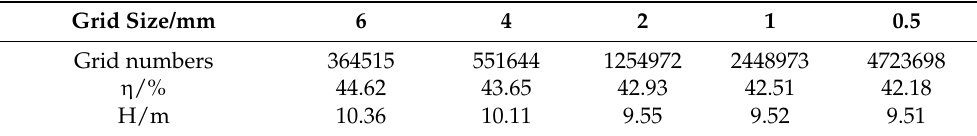
Table 3. The efficiency and head values with different grid